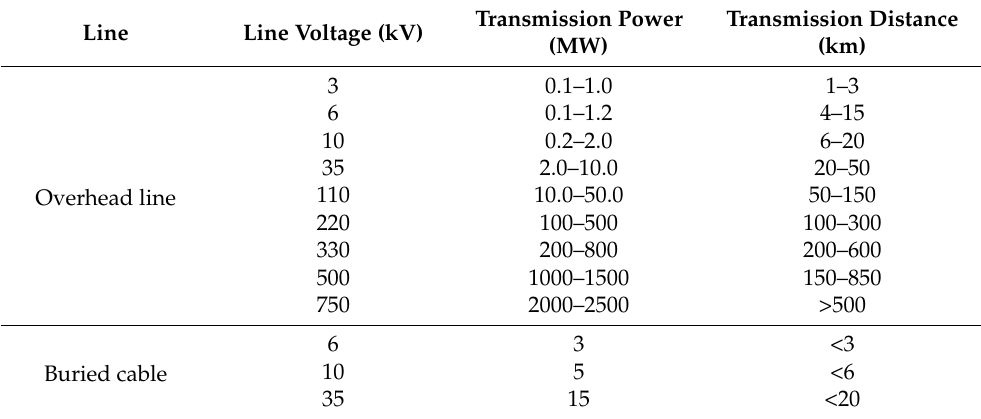
Table 3. Transmission power and distance of lines with different voltage levels [51,52].